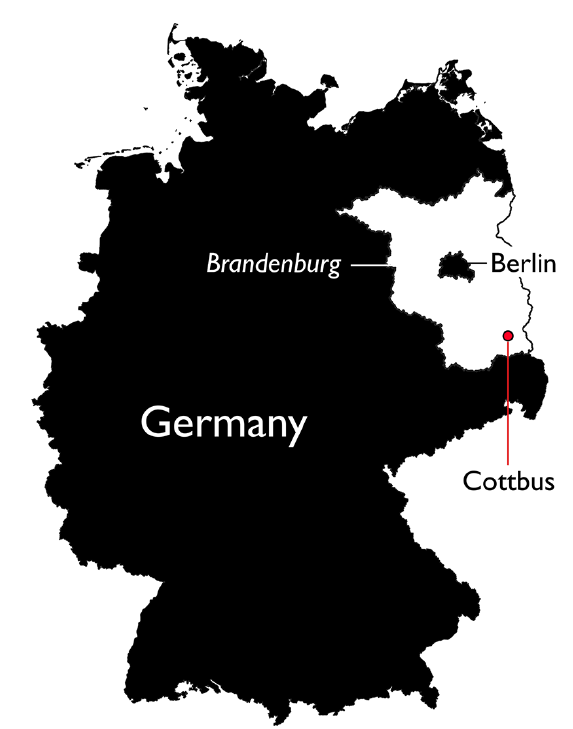
Figure 1. The location of the case study, Cottbus (in Brandenburg, Germany). The map is oriented North. Source: German Federal Agency for Cartography and Geodesy